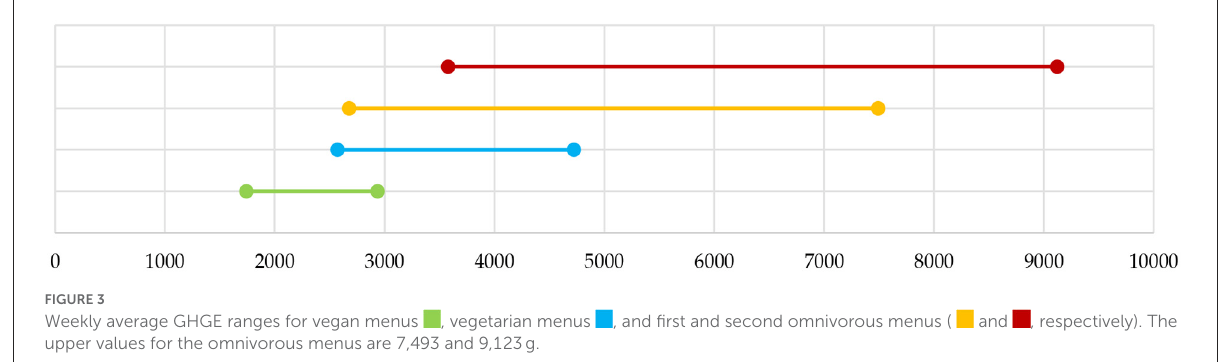
FIGURE3 Weekly average GHGE ranges for vegan menus , vegetarian menus , and first and second omnivorous menus ( and , respectively). The upper values for the omnivorous menus are 7,493 and